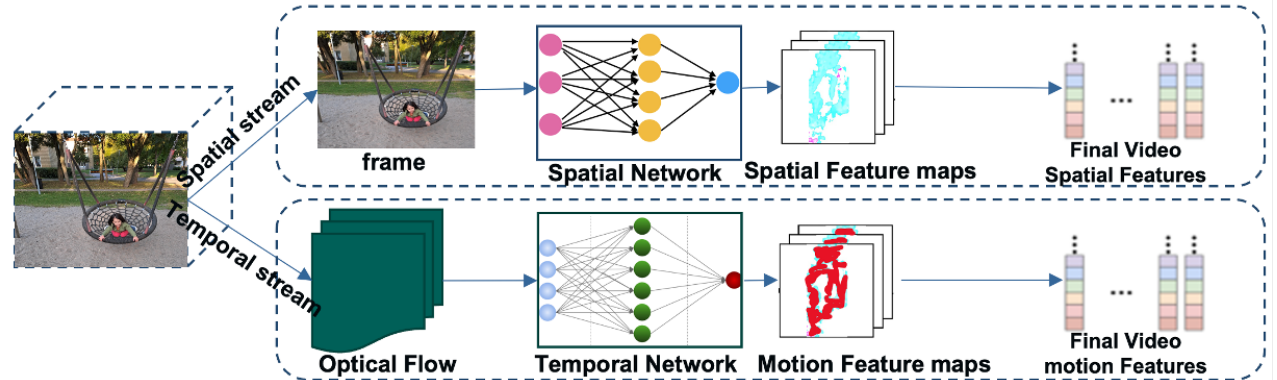
Figure 4. An example of two-stream architecture with optical flow.